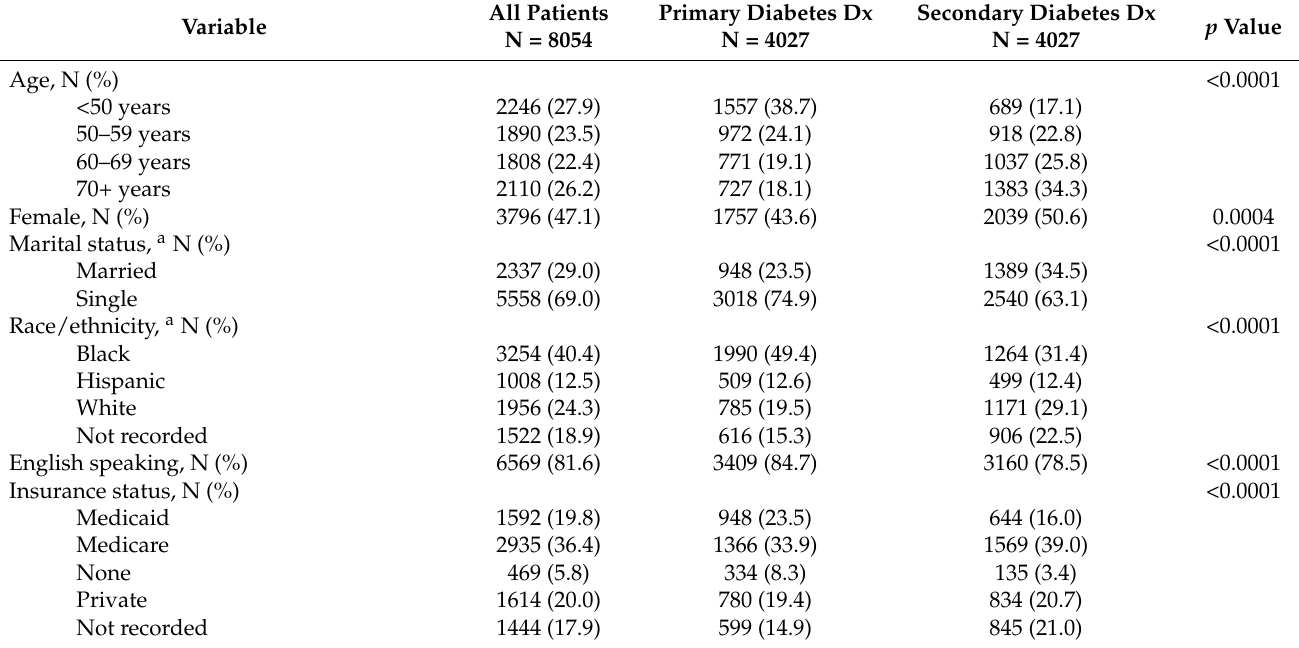
Table 1. Characteristics of the hospitalized patients by the primary or secondary discharge diagnosis of